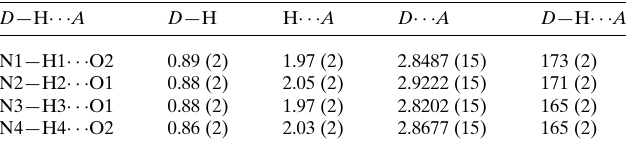
Table 1 Hydrogen-bond geometry (A˚ , (cid:4) ).